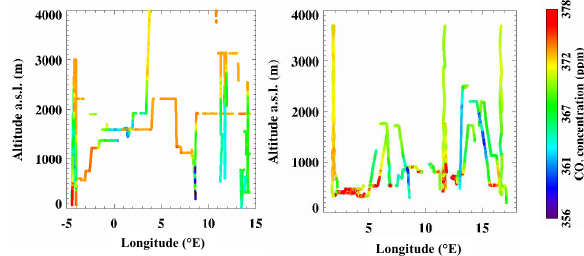
Fig. 9. CO 2 concentrations along the flight patterns represented in function of longitude and altitude during the CAATER 1 (left) and CAATER 2 (right) campaigns.